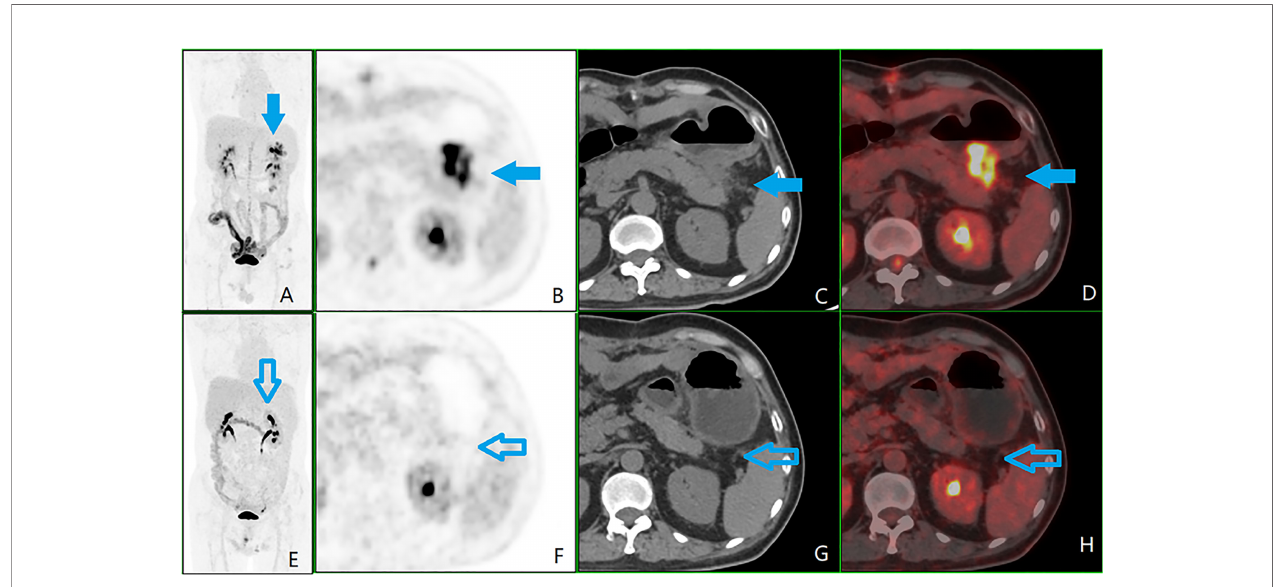
FIGURE 3 | A patient with colorectal peritoneal carcinomatosis (CRPC), male, 56 years old, operated on for ulcerative poorly differentiated adenocarcinoma of the descending colon on May 17, 2017. (A) Positron emission tomography (PET) 3D-MIP image; (B) PET cross-sectional image; (C) computed tomography (CT) cross-sectional image; (D) PET/CT fusion cross-sectional image; (E – H) and (A – D) are in the same order, which is of the second 18 F- fl uorodeoxyglucose PET/CT examination on September 11, 2018, after six courses of chemotherapy. The fi rst examination showed plaques with soft tissue density, i.e., CRPC lesions (shown by the blue arrow) in the left upper abdominal region (zone 3) next to the anterior tail of the pancreas, lesion size 2, with a peritoneal cancer index score of 2. The glucose metabolism was signi fi cantly elevated, with a standardized uptake maximum value of 20.5, a time-lapse period of 31.8, and a retention index of 55.1%. A review after completion of six courses of chemotherapy showed a signi fi cantly reduced, unde fi ned CRPC lesion (shown by the hollow blue arrow).